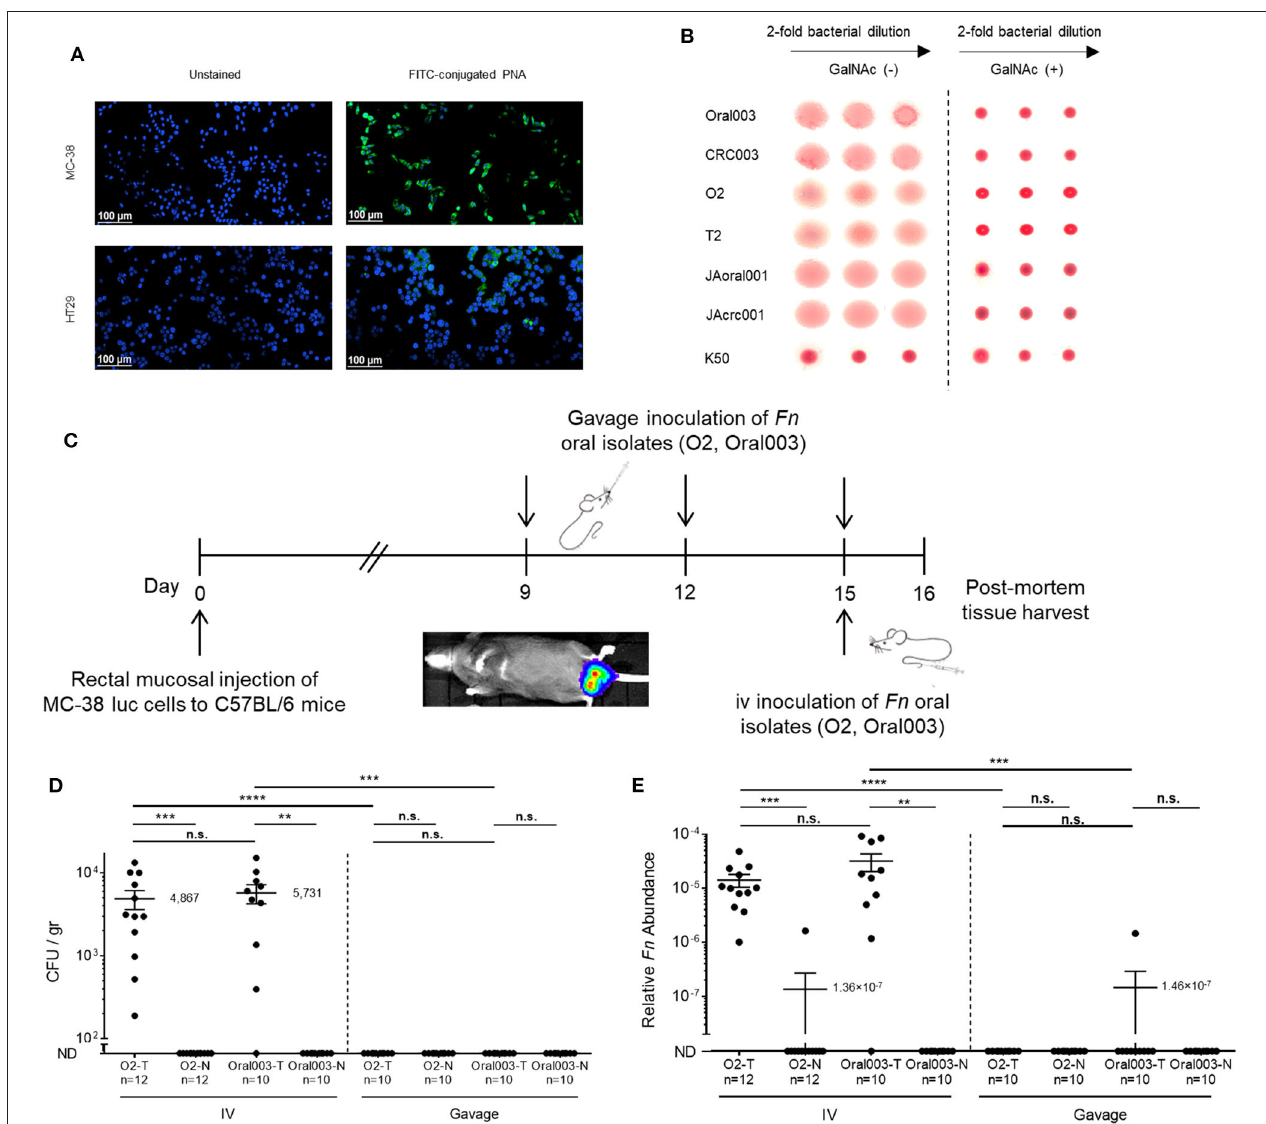
FIGURE 2 | The bloodstream is an efficient route of oral F. nucleatum for CRC enrichment. (A) MC38 mice CRC cells display high Gal-GalNAc levels. Representative images of MC38 cells and of human adenocarcinoma HT-29 cells unstained (left panels), or stained with FITC-labeled Gal-GalNAc-specific PNA (green, right panels). (B) Hemagglutination demonstrating Fap2-dependent Gal-GalNAc binding by matching oral and CRC isolates O2/T2 with Oral003/CRC003 and JAoral001/JAcrc001 in the absence (left) and in the presence (right) of 25mM GalNAc. The F. nucleatum ATCC 23726 Fap2 inactivated mutant K50 was used for negative control. Non-hemagglutinated erythrocytes settle in the bottom of the round bottom well. (C) in vivo experimental scheme of the orthotopic rectal MC38-luc mouse CRC model. At day 9 post-tumor implantation mice were randomized to an oral or intravenous inoculation group. Oral inoculations were performed on day 9, 12, and 15. A single intravenous inoculation was performed on day 15. (D,E) CRC colonization by hematogenously or orally administered fusobacteria. (D) Abundance (CFU/gr tissue) and relative fusobacterial gDNA abundance (2 − 1 Ct ) (E) in tumor (T) samples and in adjacent normal (N) colon samples from MC38 transplanted mice inoculated once with 5 × 10 6 -1 × 10 7 intravenously (IV) or three times by oral gavage (Gavage) with 10 ∼ 10 F. nucleatum O2 or Oral003. **** p < 0.0001, Bonferroni-corrected two-tailed Mann-Whitney test. *** p < 0.001 Bonferroni-corrected two-tailed Mann-Whitney test for gavage vs. IV, Bonferroni-corrected one-tailed Wilcoxon test for tumor vs. normal. ** p < 0.01 Bonferroni-corrected one-tailed Wilcoxon test. n.s., not statistically significant. Each symbol represents data from individual mice. Error bars show Mean ± SEM.